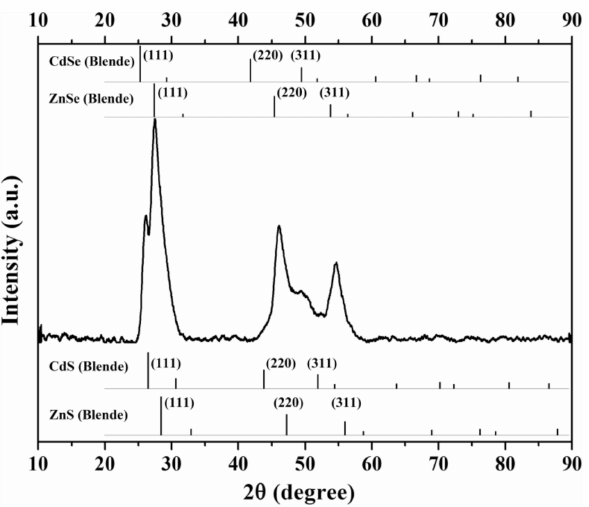
Figure 1. XRD patterns of CdZnSeS-pATP and the theoretical patterns of zinc-blende CdSe, ZnSe, CdS and ZnS.